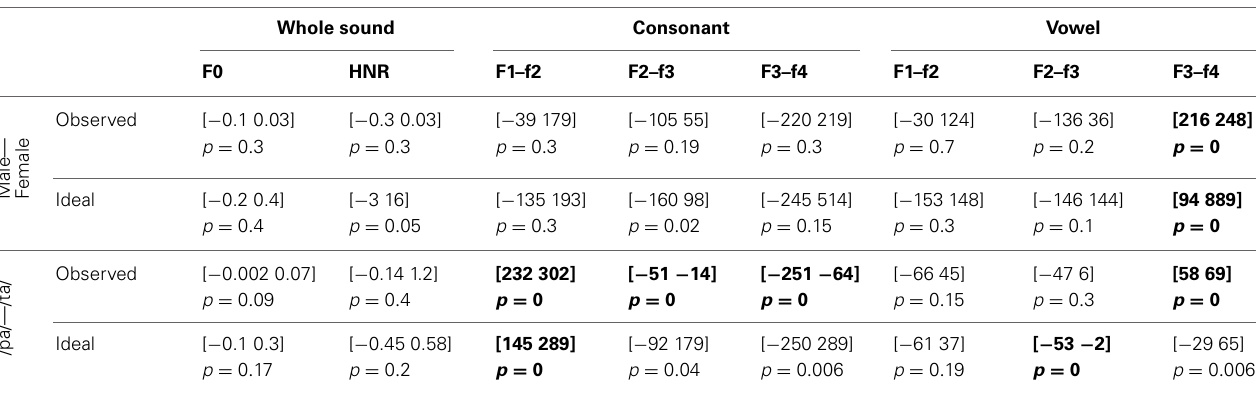
Table 7 | Reverse correlation results for f0-equalized sounds.